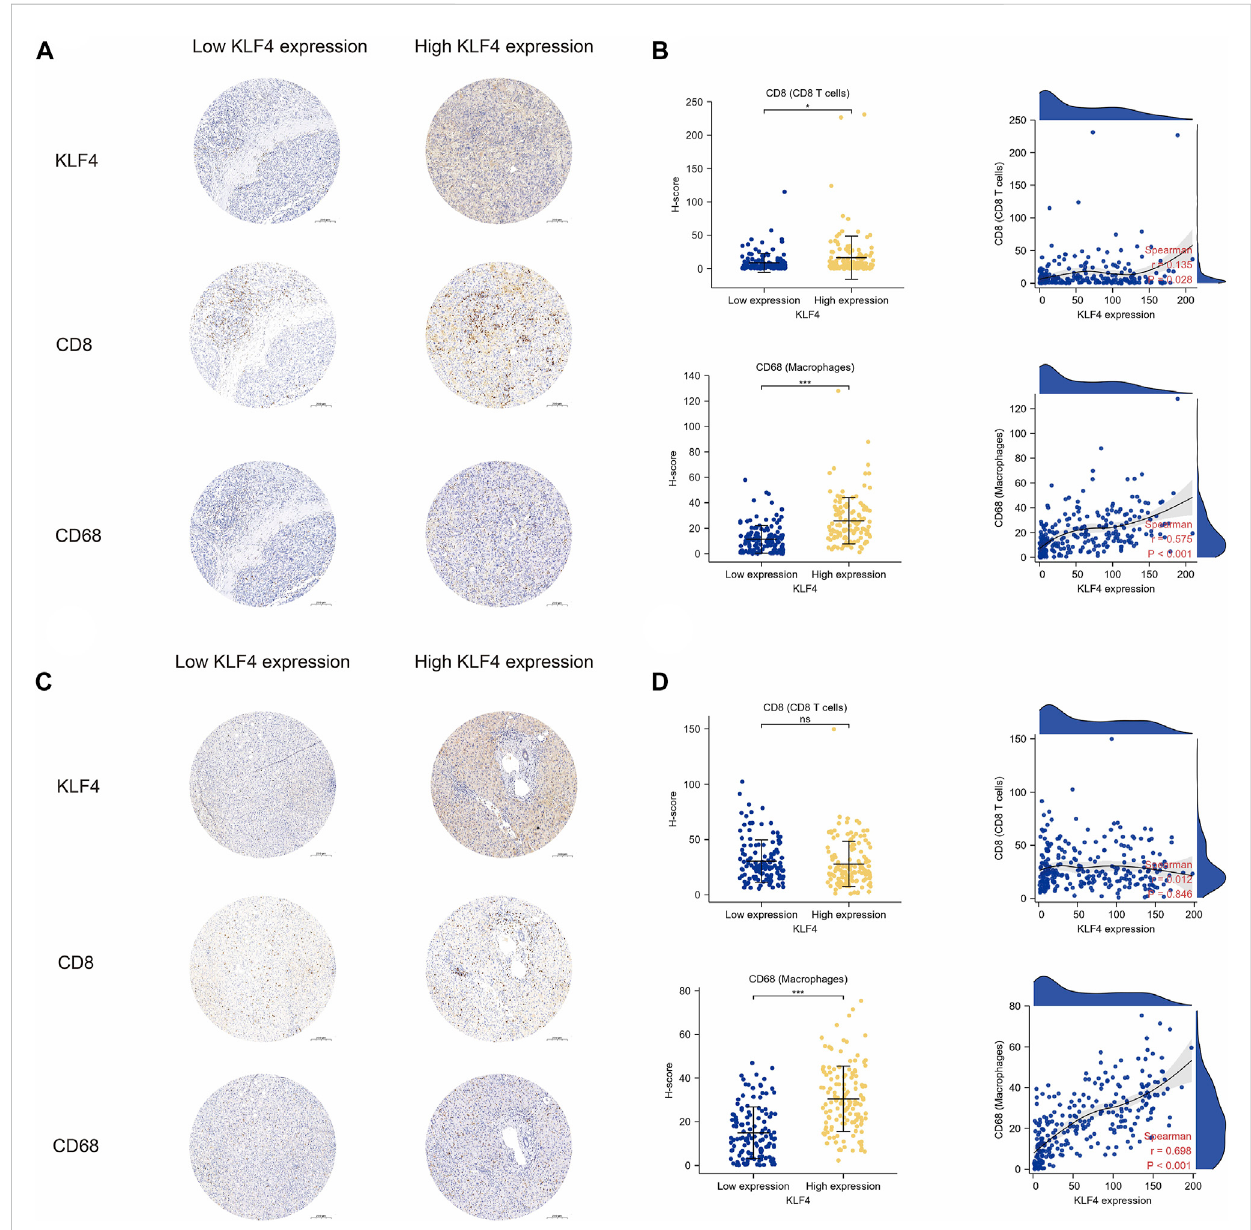
FIGURE 6 Validation of immune cell in fi ltration in tumors with KLF4 high expression (A) Representative images of KLF4 expression, CD8 + T cells, and macrophage in fi ltration in HCC tumor tissues with low-/high-KLF4 expression, respectively (B) The CD8 + T cells, and macrophage in fi ltration level in HCCtumortissuesbetweenlow-/high-KLF4 expressiongroupaswellascorrelationanalysis (C) RepresentativeimagesofKLF4 expression,CD8 + Tcells, and macrophage in fi ltration in HCC adjacent normal tissues with low-/high-KLF4 expression, respectively (D) The CD8 + T cells, and macrophages in fi ltration level in HCC adjacent normal tissues between low-/high-KLF4 expression group as well as correlation